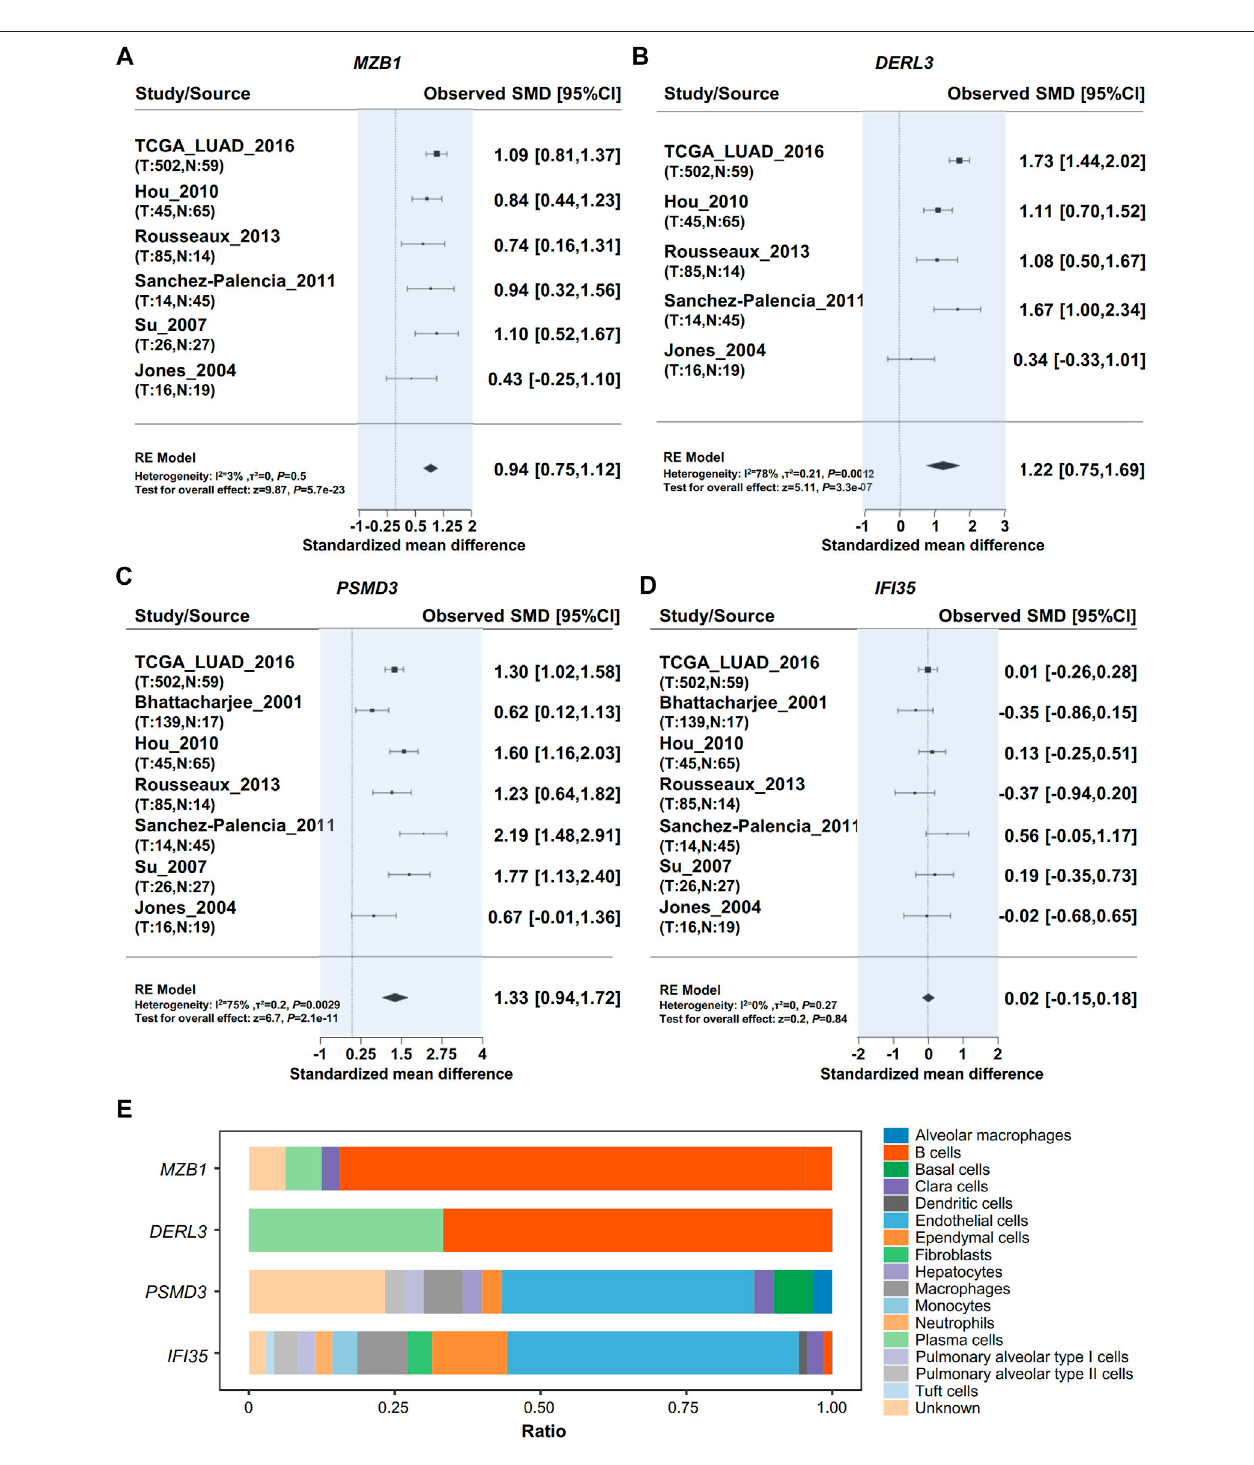
FIGURE 4 | Validation of hub gene expression. Meta-analysis of Hub gene expression by using the Lung Cancer Explorer database. (A) MZB1, (B) DERL3, (C) PSMD3, (D) IFI35. (E) Analysis of cells expressing RR hub genes (MZB1, DERL3) and RS hub genes (PSMD3, IFI35) in the lung tissue with PanglaoDB.